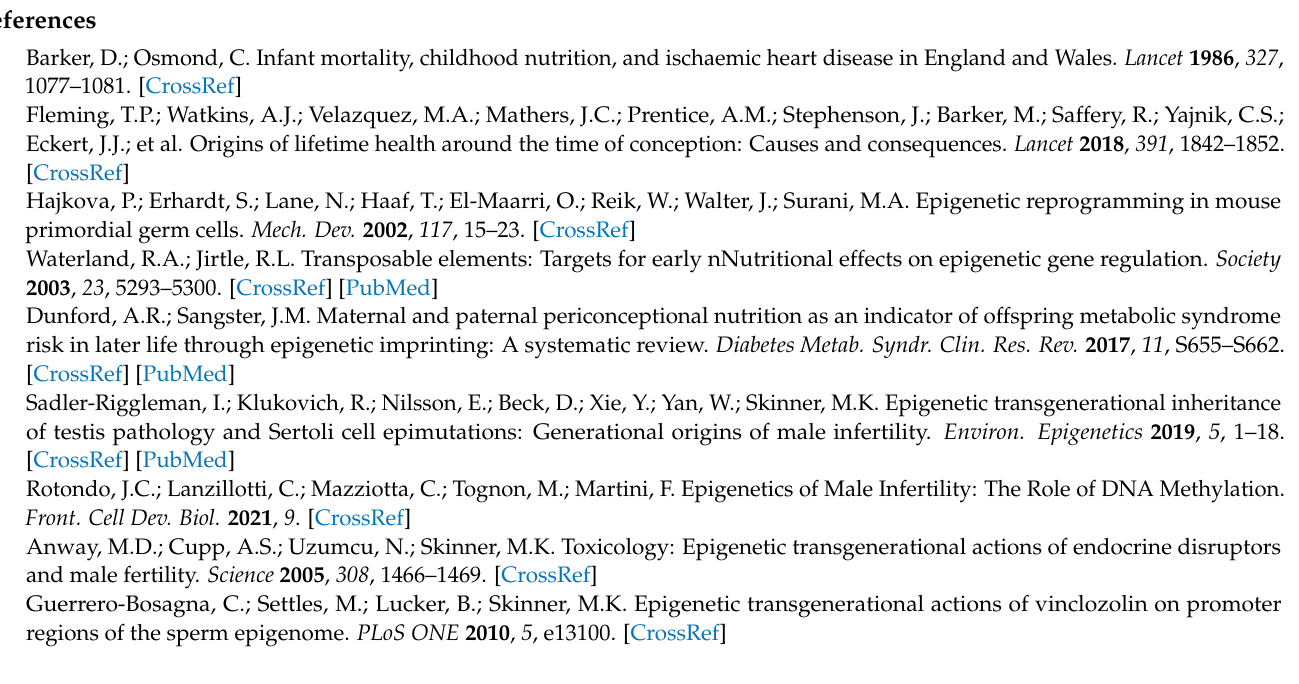
Table S1: Fatty acid profile of the Laboratory Rodent diet 5001 and vehicle (Nutrioli ® soybean oil). Table S2: FA supplementation across generations and offspring weight. Table S3: Reproductive parameters of FA-supplemented and non-supplemented three-month-old dams. Table S4: Offspring organ weight and correlation with mg of FA exposure. Table S5: Analysis of liver tissue of one-month old offspring of FA-supplemented mice. Table S6: Correlations between liver weight, total fat, and FA (individual and by degree of saturation) across three offspring generations. Table S7: Global DNAm and Scd1 . Ppargc1a promoter methylation of liver from one-month-old offspring of FA supplemented